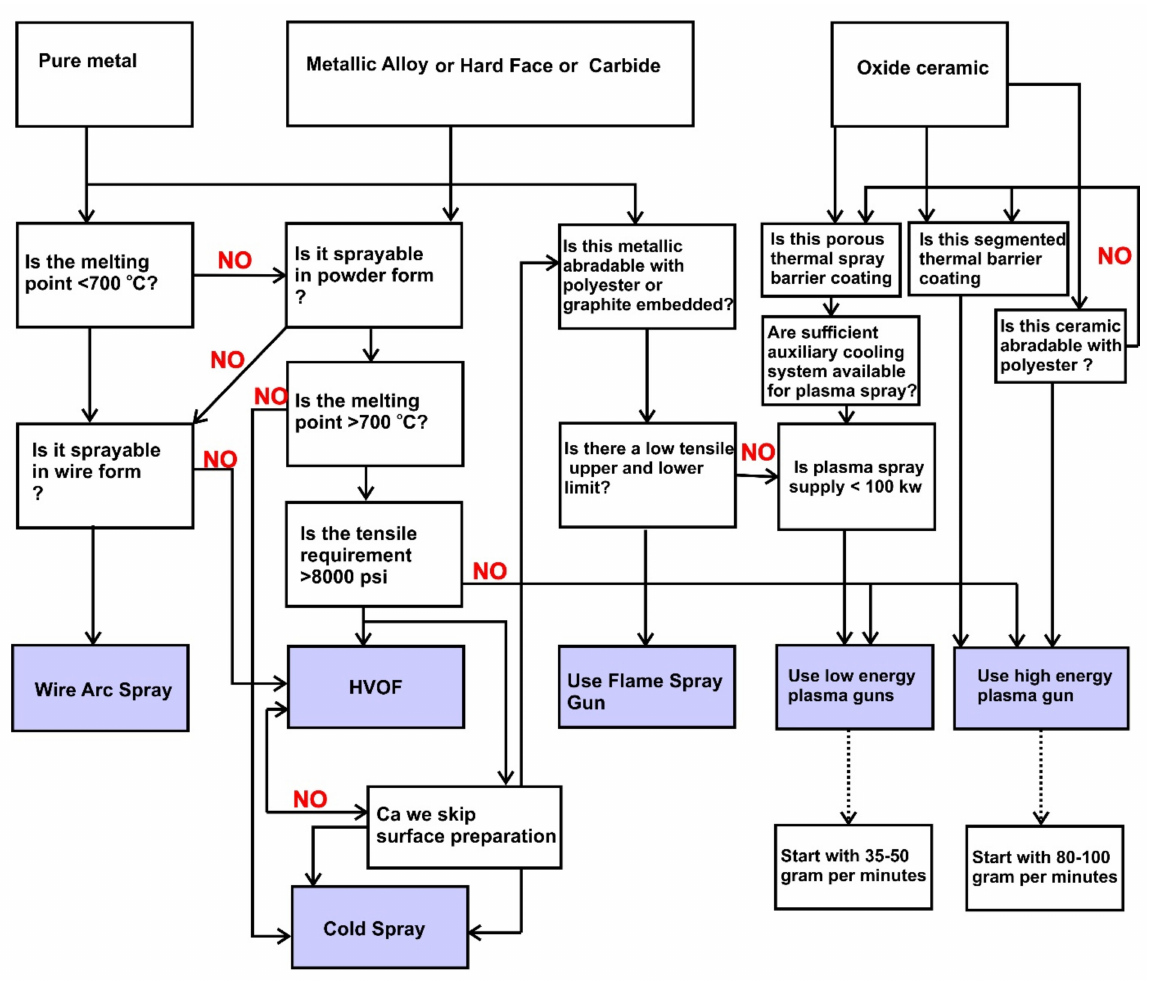
Figure 1. Flow chart for decision-making process in selecting the appropriate spraying